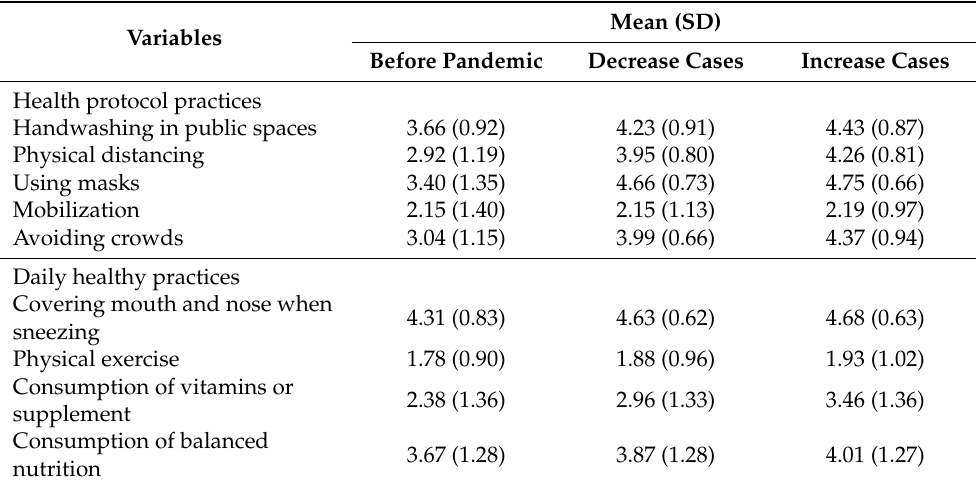
Table 2. Descriptive analyses of health protocol practiced by respondents.